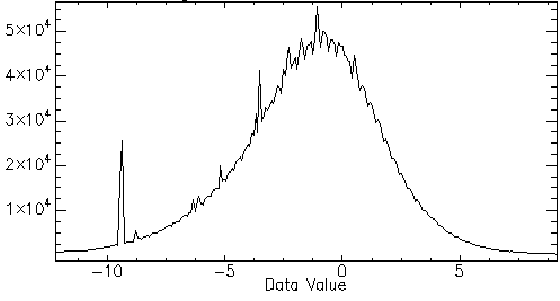
Figure 4. Frequency distribution of the differential DSM between the twin ZY-3 DSMs The color mapping of the differential DSM (D-DSM) by the standard deviation can be used to identify the big height discrepancies (figure 5). The size of discrepancies is indicated in the order of red, yellow, blue, and green, respectively, where the red region indicates greater than 3 times standard deviation. The bias and standard deviation of height in the tables 5 and 6 is analyzed, and the function can be described by Formula 2.